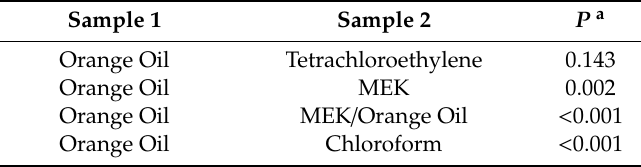
Table 1. Pairwise comparisons of solvent for weight loss after the Kruskal–Wallis test.